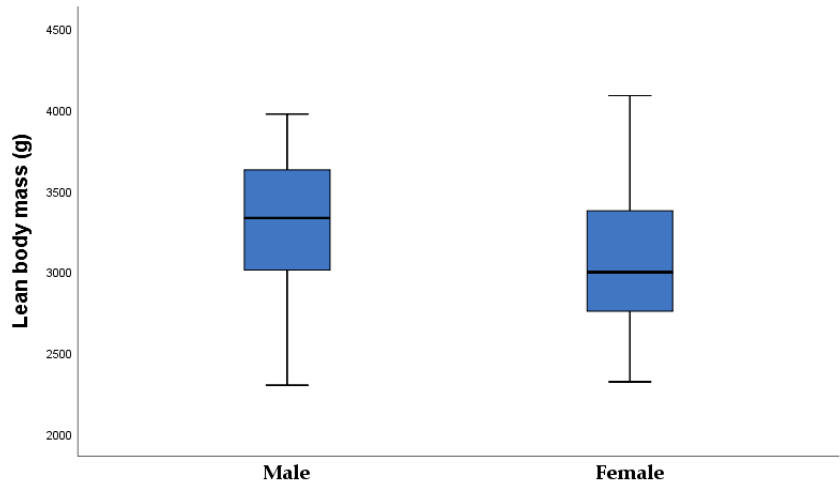
Figure 8. Lean body mass in male and female neonates (male 3294.8 ± 479.6: female 3046.2 ± 465.2, p = 0.037).